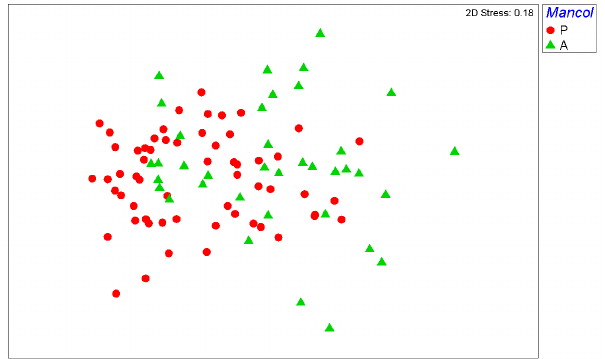
Figure 3. Non-metric multi-dimensional scaling graph pro- duced from Bray Curtis functional similarity of 96 sites using bird, log(x + 1) transformed functional group density data. Solid red circles are sites colonized by either Manorina species (average density of M. melanocephala or M. flavigula $ 2.5), solid green triangles are sites where colonies are absent. The graph demonstrates a smaller dispersion of sites (functional homogenization) where Manorina colonies are present compared to sites where colonies are absent.